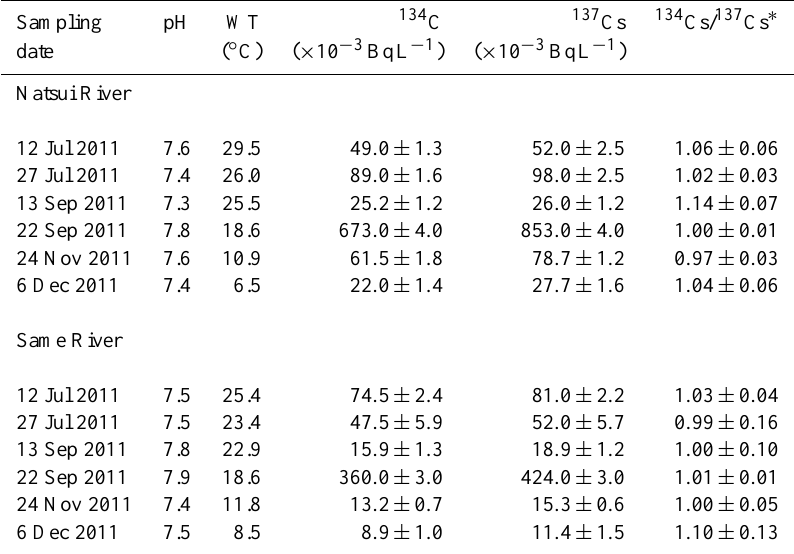
Table 1. Water quality and radioactivity of 134 Cs and 137 Cs in water samples from the Natsui River and the Same River.